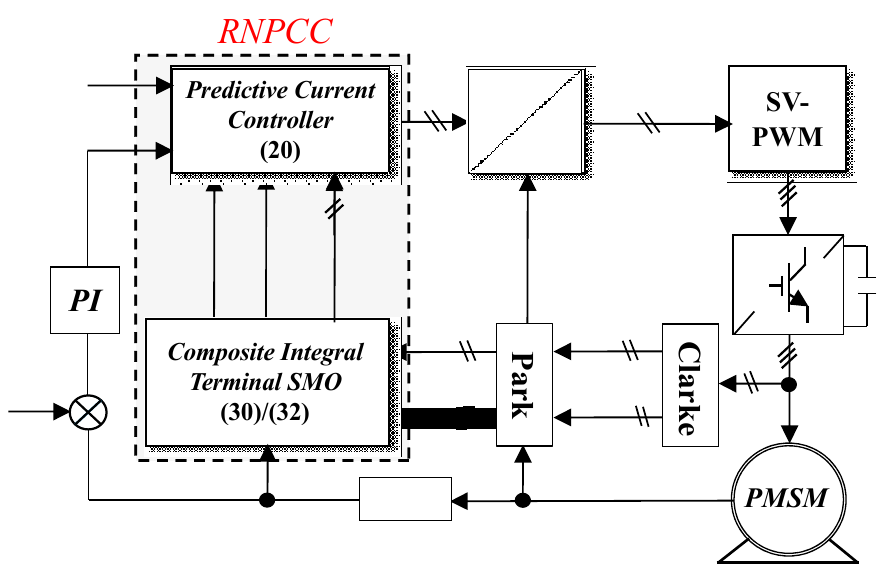
Figure 3. Block diagram of the RNPCC method with composite integral terminal sliding mode observer (SMO) for permanent magnet synchronous motor (PMSM).